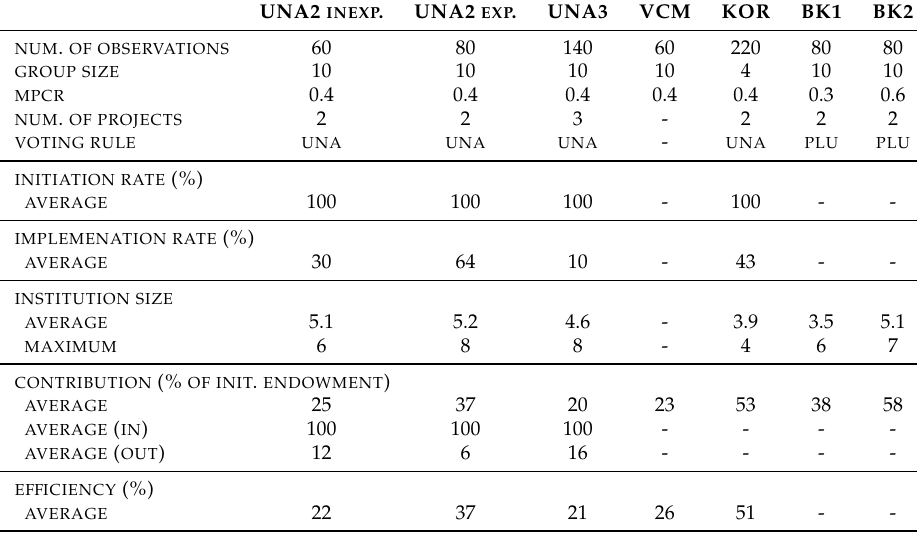
Table 4. Summary of experimental results (part